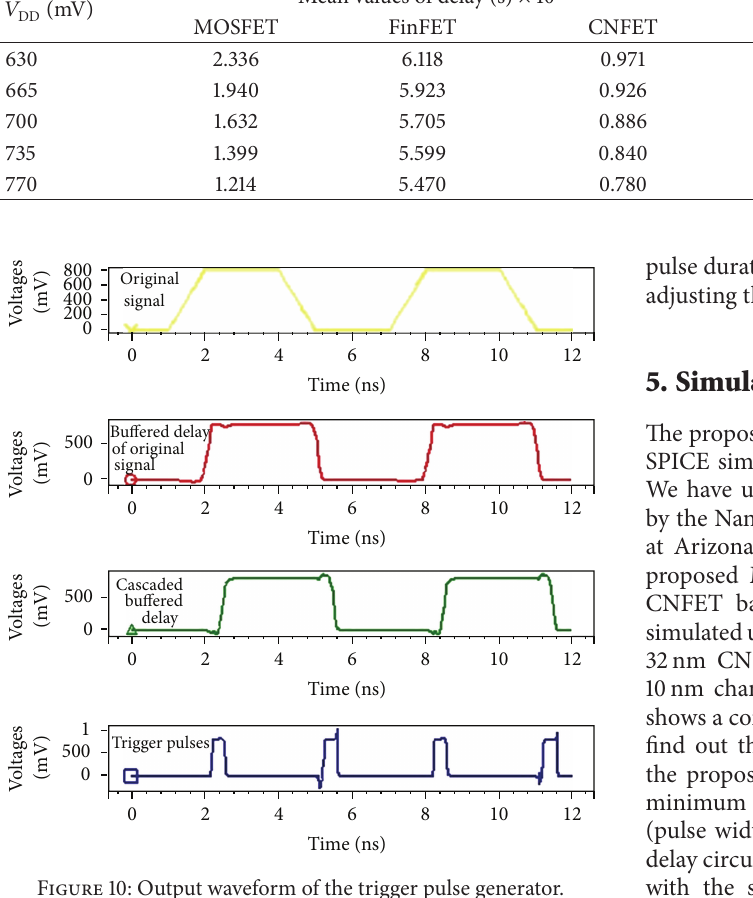
Table 1: Comparison between MOSFET, FinFET, and CNFET based on proposed buffered delay circuit. 𝑉 (mV) DD